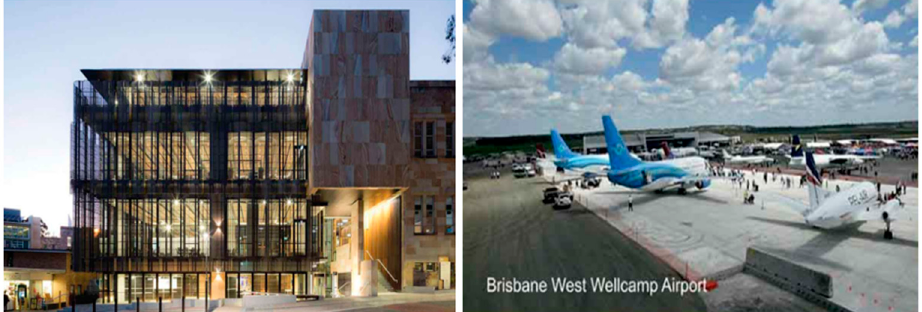
Figure 19. Global change institute building and Brisbane airport [12].